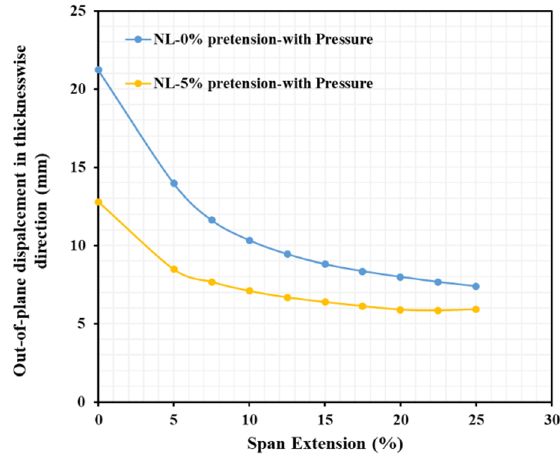
Figure 12. Out-of-plane skin deformation in thicknesswise direction.